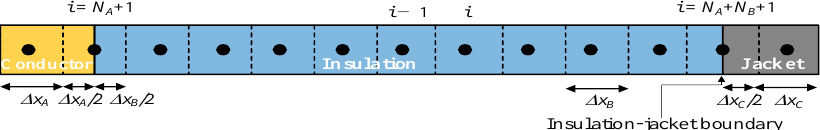
Figure 6. Inner insulation layer discretization.